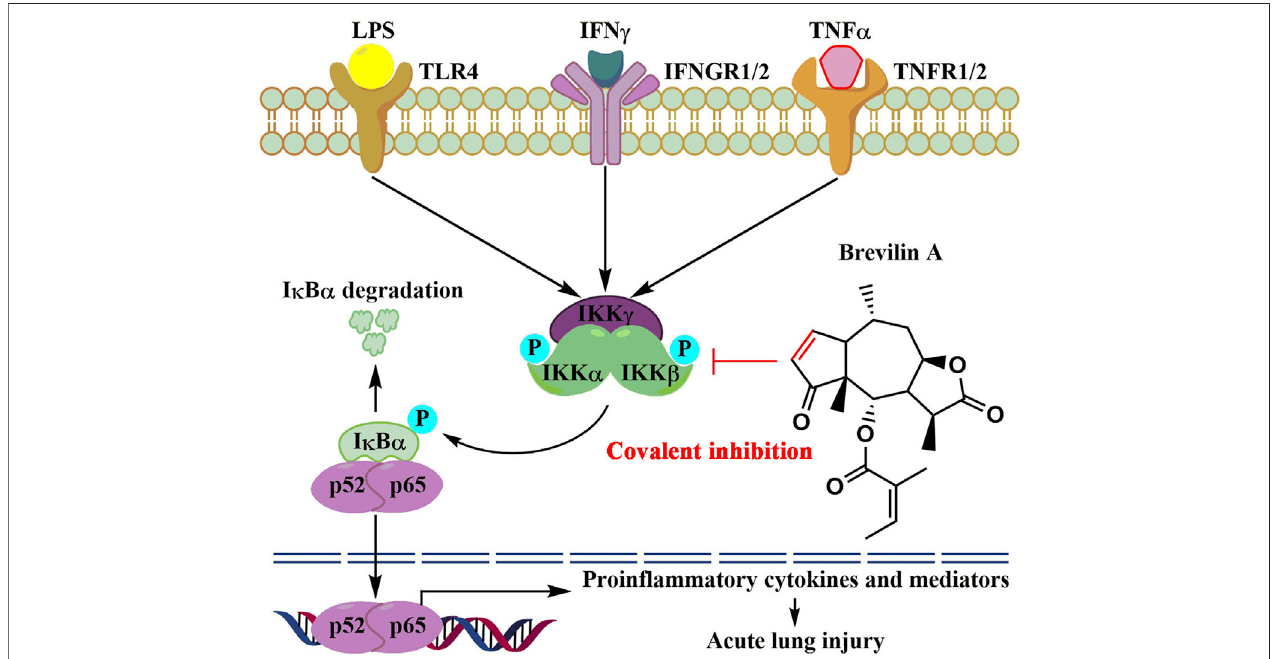
FIGURE 7 | The proposed molecular action model of brevelin A (BVA)-mediated anti-in fl ammatory activity.